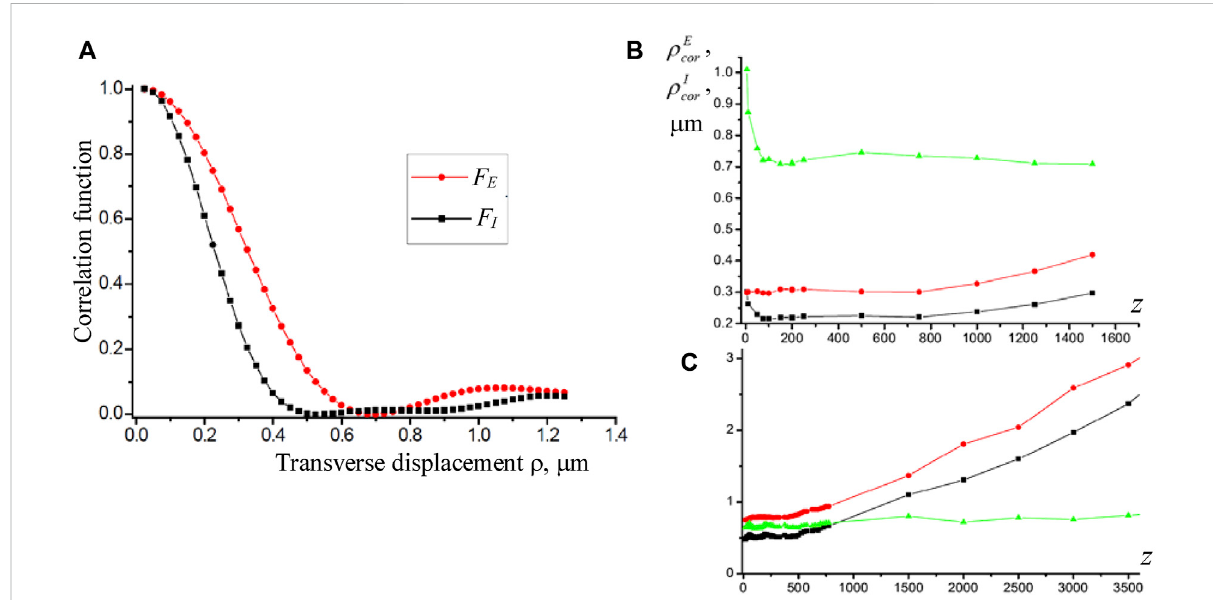
FIGURE 11 (A) Correlation functions of amplitude F E ( r ) (14) and intensity F I ( r ) (15) probed at a distance z = 100 μ m from the object; z -dependencies of the correlationlengthsofamplitude ρ E